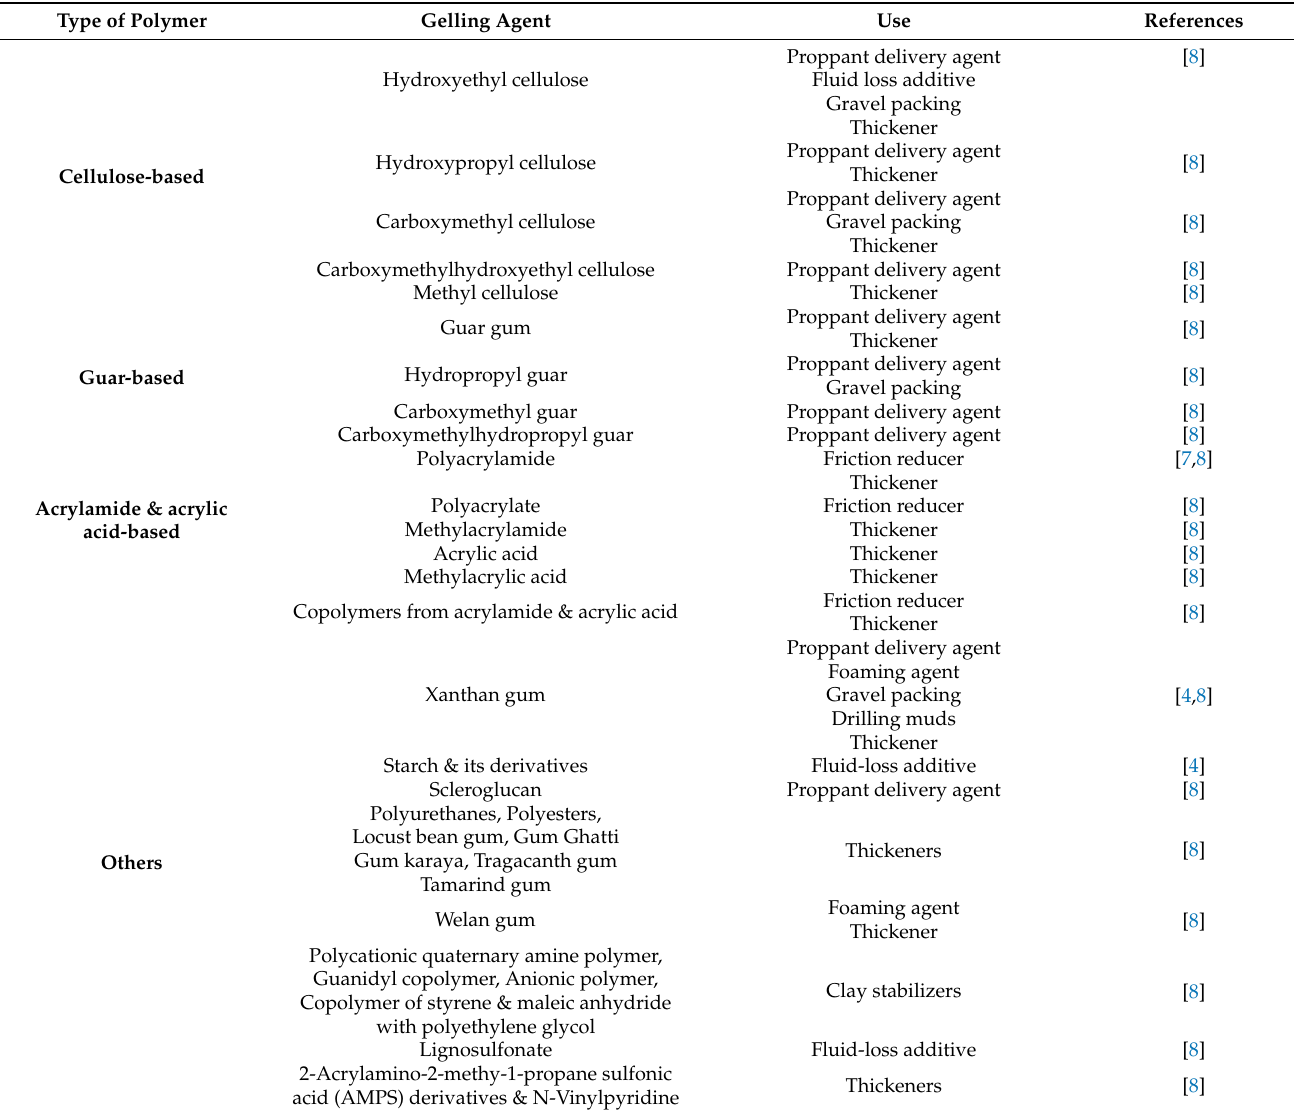
Table 1. Most commonly used polymers and their use in different steps of the hydraulic fracturing